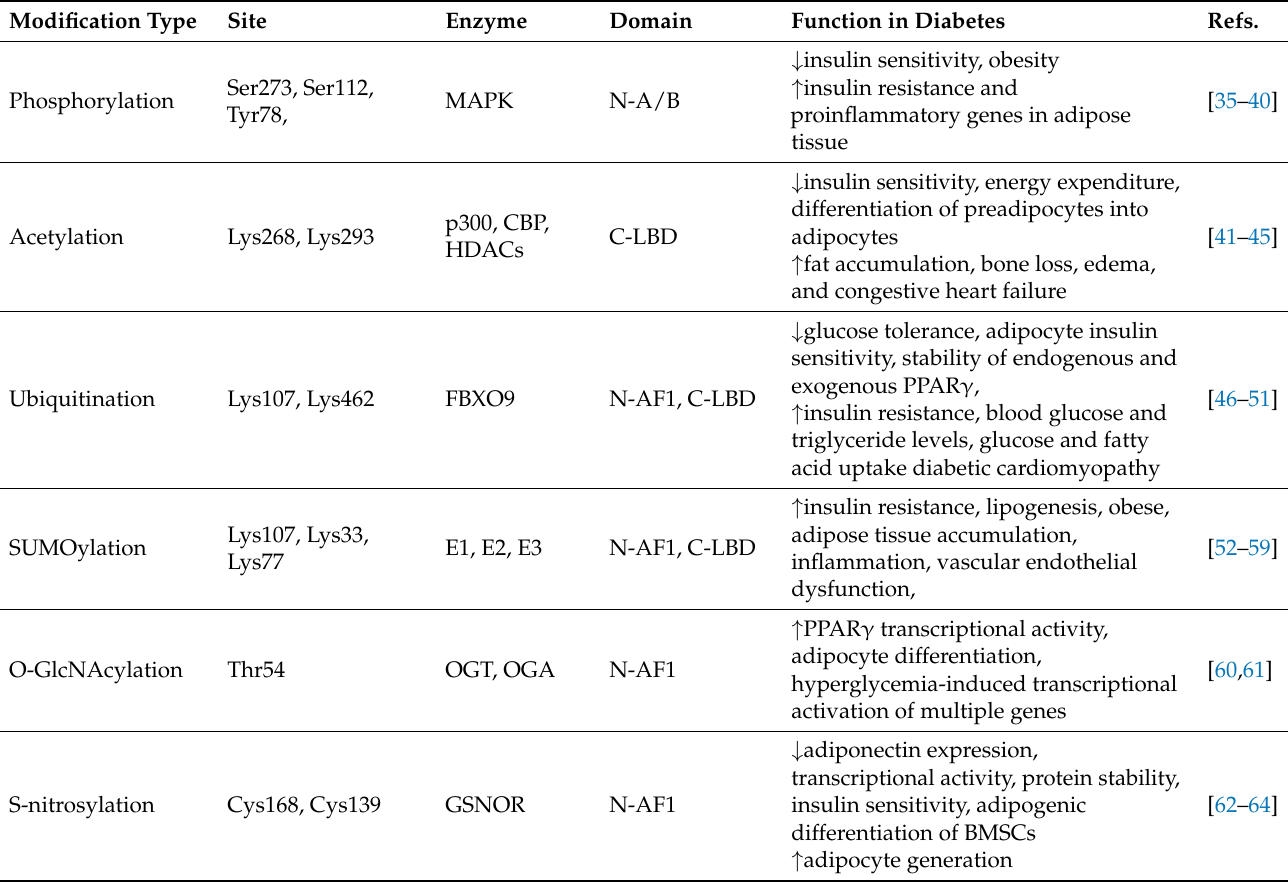
Table 1. PPAR γ modification site and function in